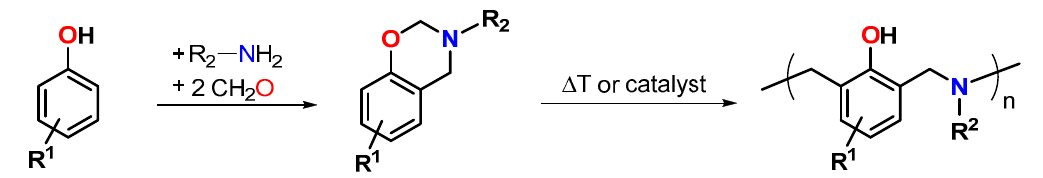
Figure 23. Schematic representation of the synthesis and polymerization of benzoxazine monomers.